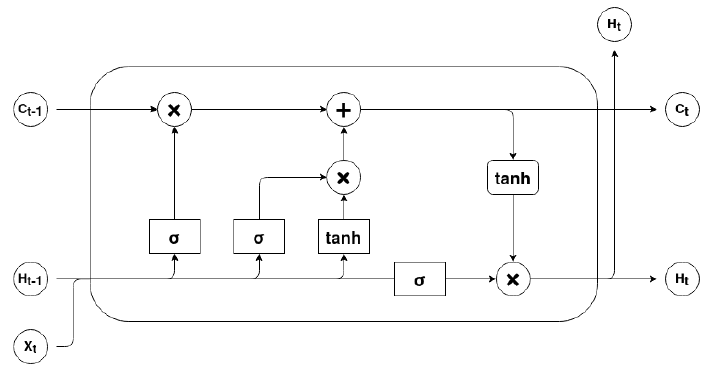
Figure 4. Basic LSTM cell architecture (adapted from [34]).